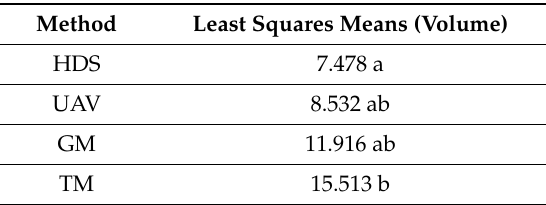
Table 4. Statistical analysis of the 4